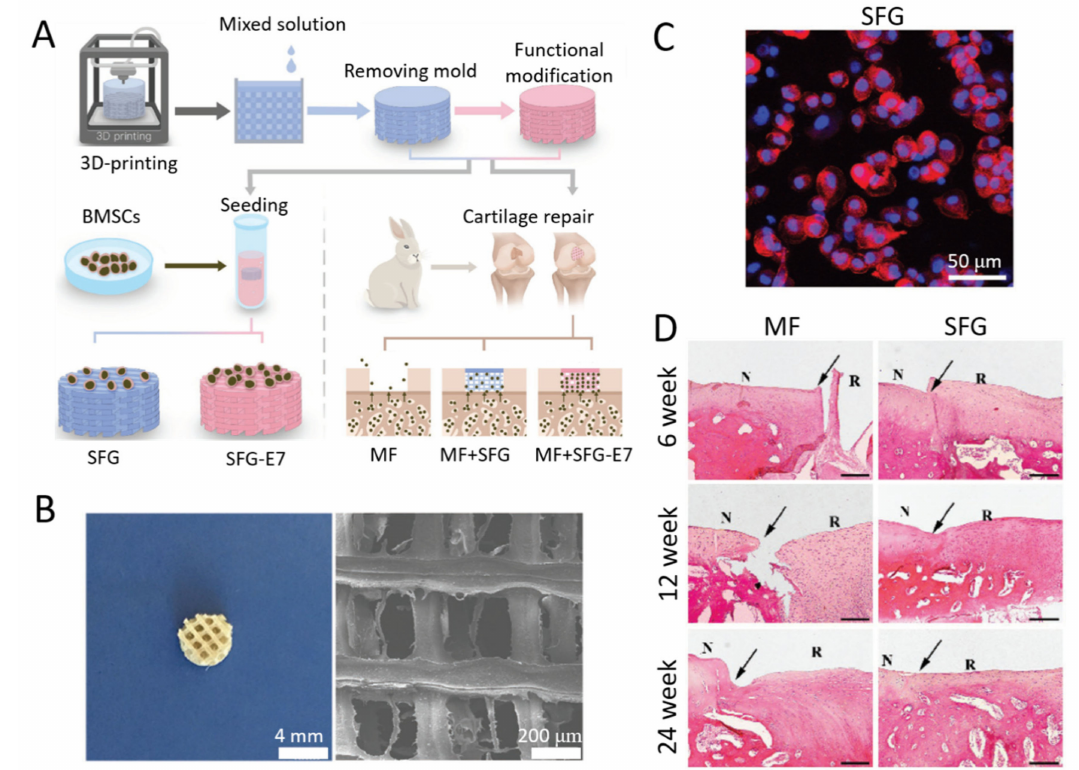
Figure 7. ( A ) Schematic diagram illustrating the fabrication of a 3D of scaffold made via Bioprinting up to the final in vivo implantation. ( B ) Microscopy and SEM images of the RSF-Gelatin scaffold (mixture of SF solution and gelatin solution at a mass ratio 1:2). ( C ) Phalloidin/Hoechst assay of chondrogenic morphology on the SFG scaffold after 21 days incubation. ( D ) Hematoxylin-eosin staining of repaired cartilage at 6, 12, and 24 weeks. (MF represents the microfracture control group; N represents normal cartilage; R represents repaired cartilage; the margins between repaired and normal cartilage are indicated by black arrows; scale bar: 200 µ m). Reprinted with permission from